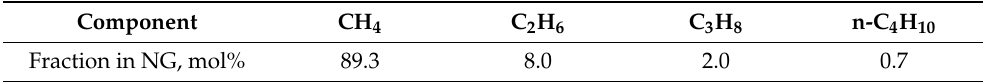
Table 1. Composition of studied wet natural